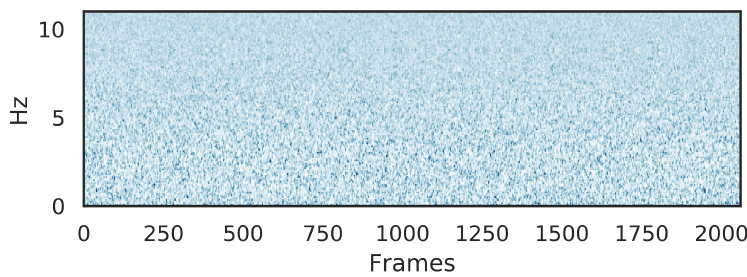
Figure 2. The mel-spectrum of the underwater acoustic ship